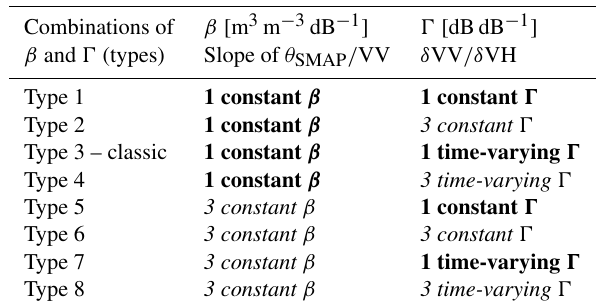
Table 4. Combinations of the downscaling parameters β and (cid:48) ap- plying the classic algorithm with one parameter for the entire area (indicated in bold) and different types applying cluster-dependent parameters (indicated in italics